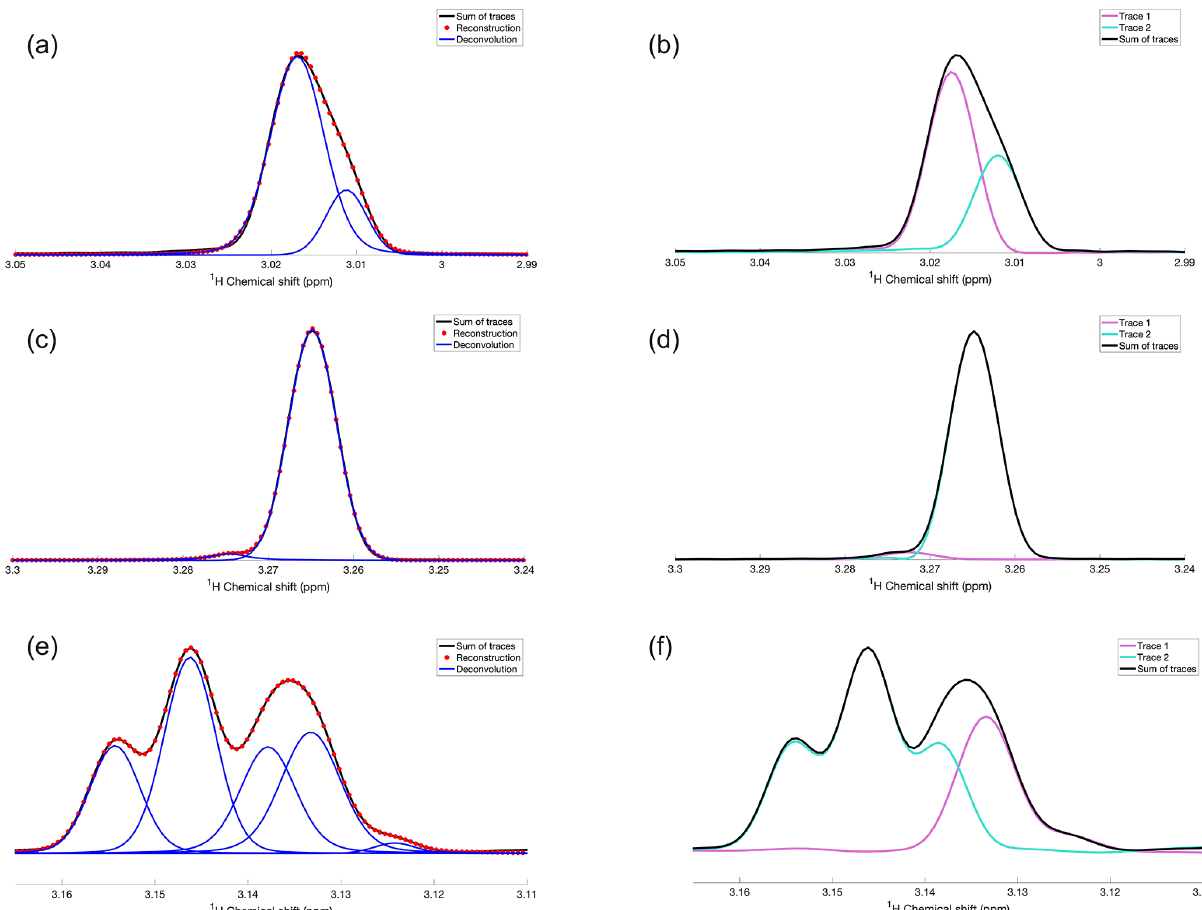
Figure 2. Application of DEEP Picker1D and Voigt Fitter1D to selected regions of 1D spectra, which were generated by adding two selected traces along the direct 1 H dimension from the experimental 2D 13 C– 1 H HSQC of a mouse urine sample. ( a , c , and e ) Experimental and reconstructed spectra are depicted as black lines and red dots, respectively. Deconvoluted individual peaks are depicted as blue lines. ( b , d , and f ) The two HSQC traces and their sum are depicted as purple, cyan, and black lines, respectively. Pairs of panels (a, b) , (c, d) , and (e, f) show the same 1D spectral regions for comparison. The deconvolution by DEEP Picker1D was performed with model 1 with a PPP number of